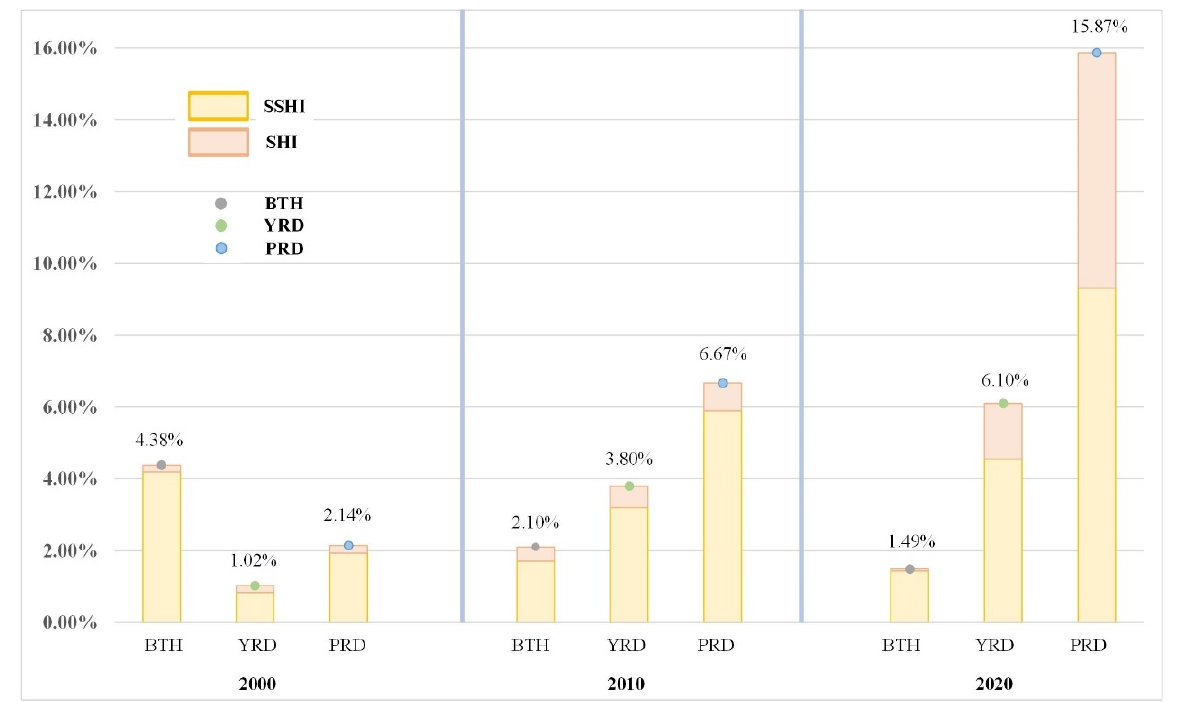
Figure 5. Area ratio of strong heat island (SHI) and sub-strong heat island (SSHI) zones of three urban agglomerations. BTH, Beijing–Tianjin–Hebei; YRD, Yangtze River Delta; PRD, Pearl River Delta.